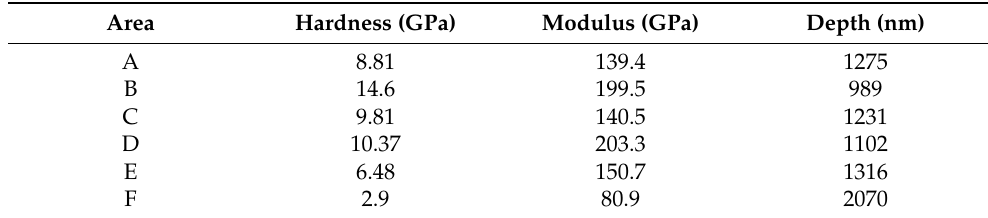
Table 3. Mechanical properties at different areas of the coating cross-section measured by the nanoindentation test.